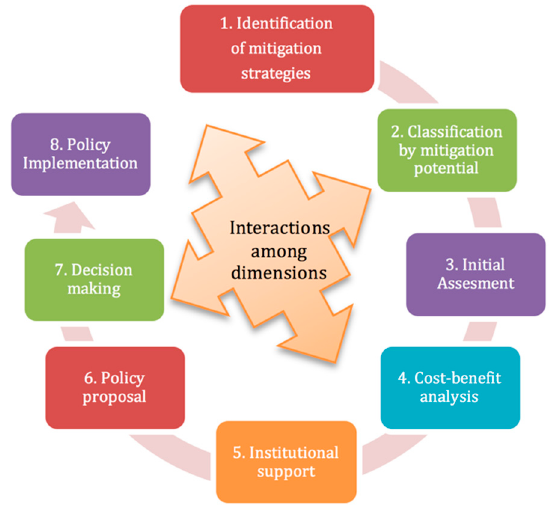
Figure 1. Proposed eight-step multidimensional methodology.